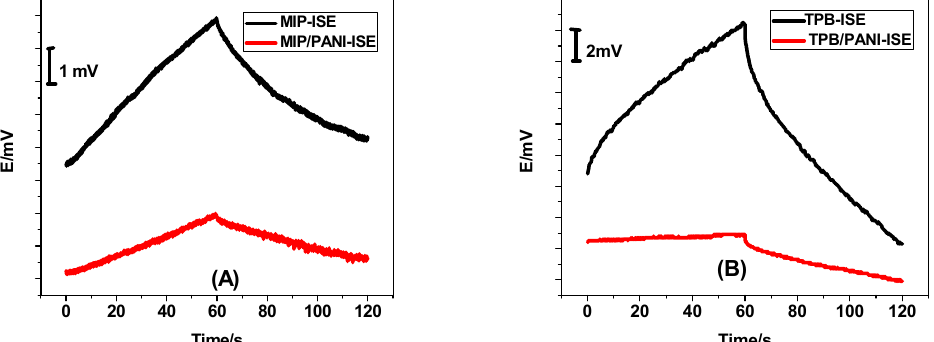
Figure 6. Chronopotentiometry for CYR-ISE ( A ) MIP and ( B ) TPB, with / without PANI solid contact.